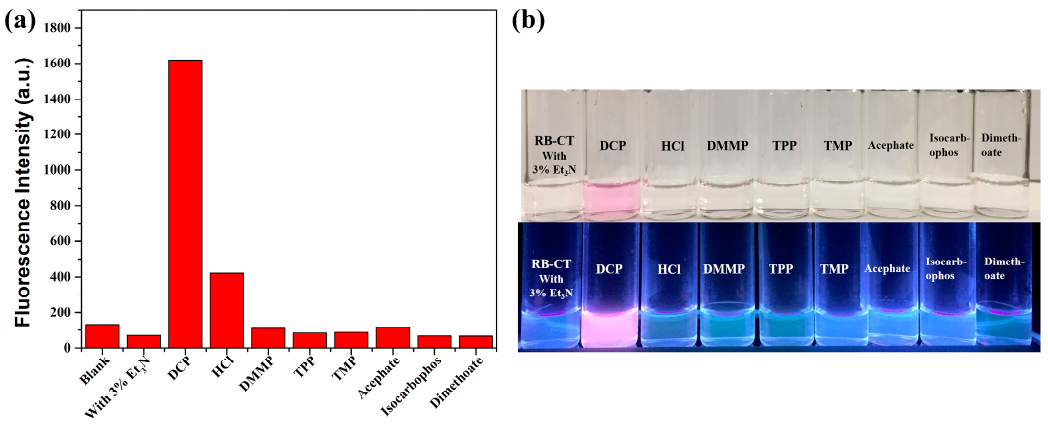
Figure 4. ( a ) Relative fluorescence intensity of RB-CT (1 × 10 − 5 M, CH 3 CN, 3% Et 3 N) at 583 nm after the addition of different organophosphorus compounds (1.0 × 10 − 3 M). Blank is the CH 3 CN solution of RB-CT without Et 3 N. ( b ) Relative color change of RB-CT after the addition of different organophosphorus compounds under sunlight and UV light.